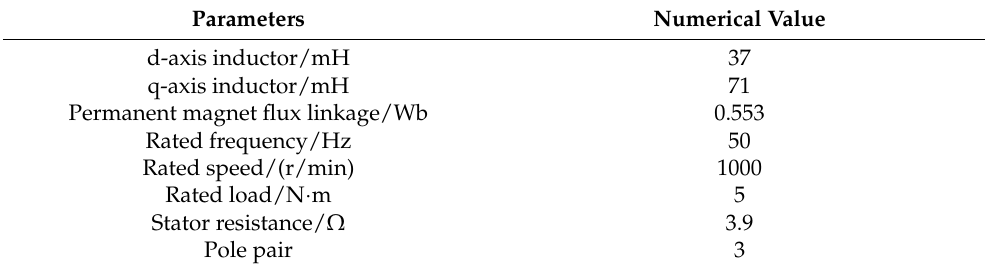
Figure 9. Experimental platform. Table 1. OW-PMSM parameters.